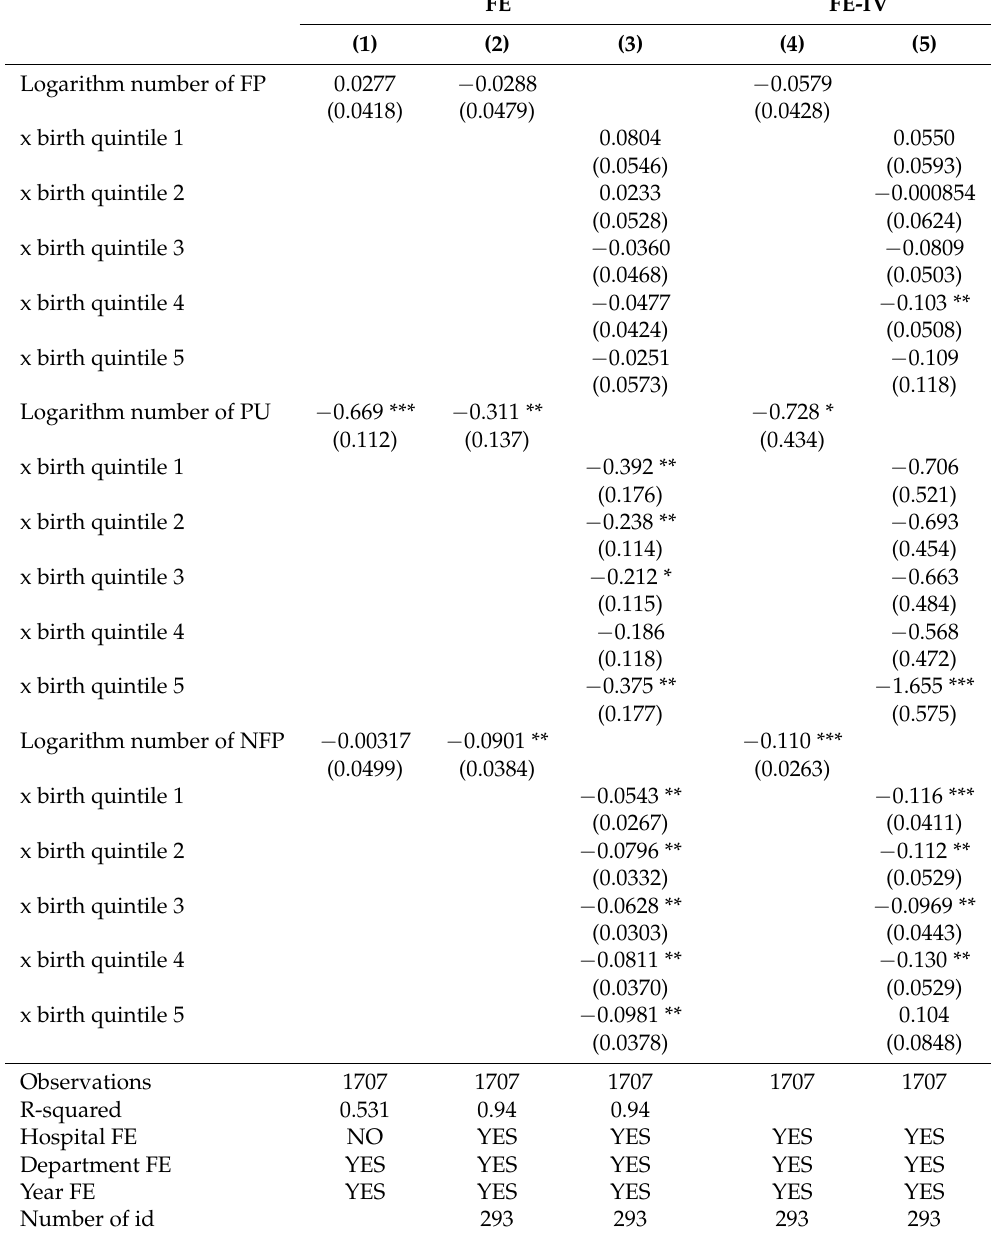
Table 5. Reduced analysis on substitution between maternity units: Focal unit is